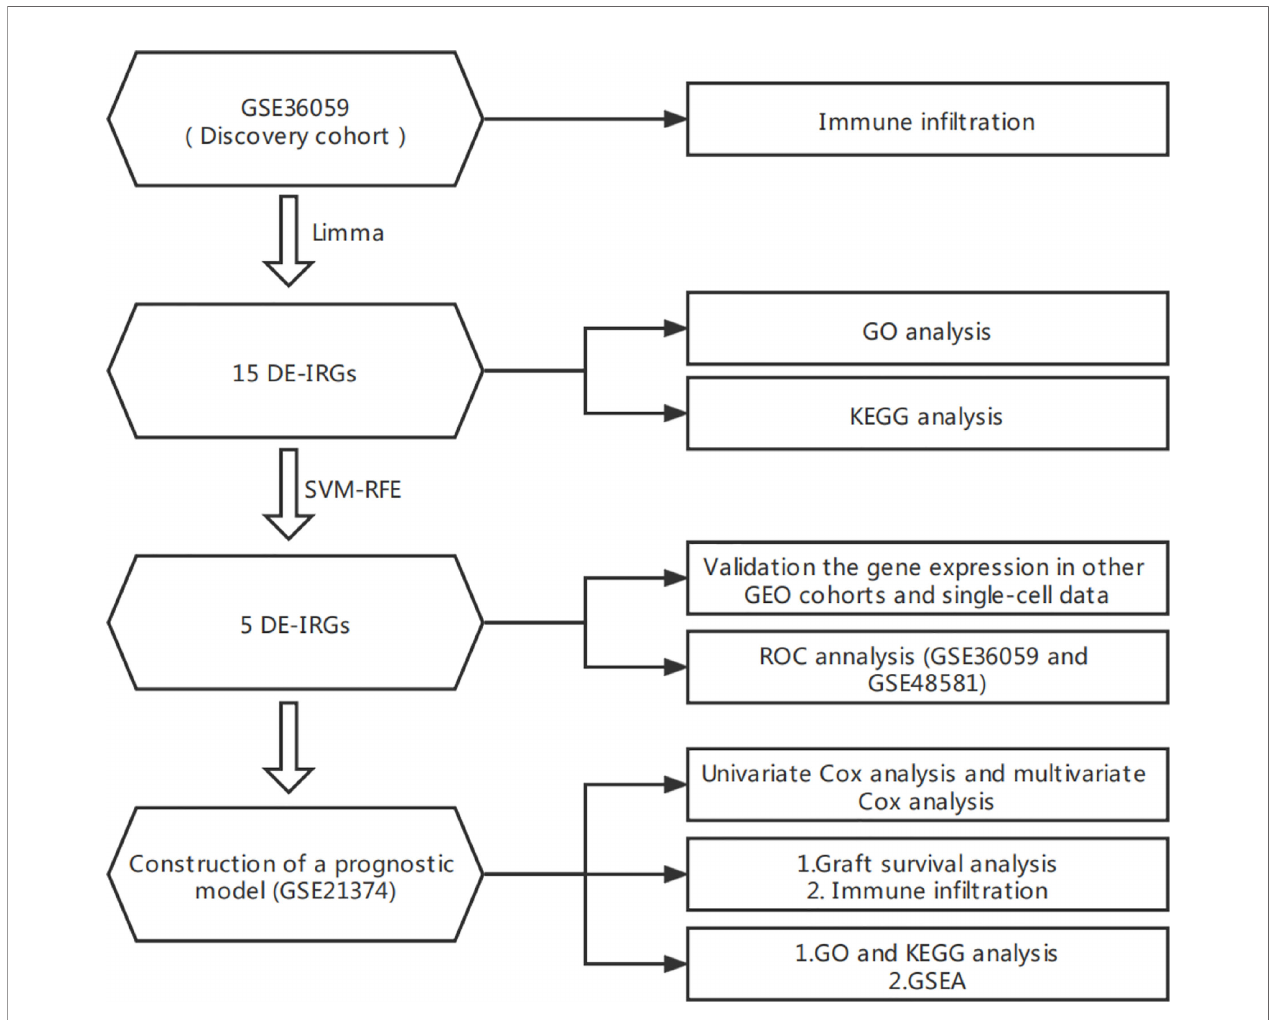
FIGURE 1 | Flowchart of this